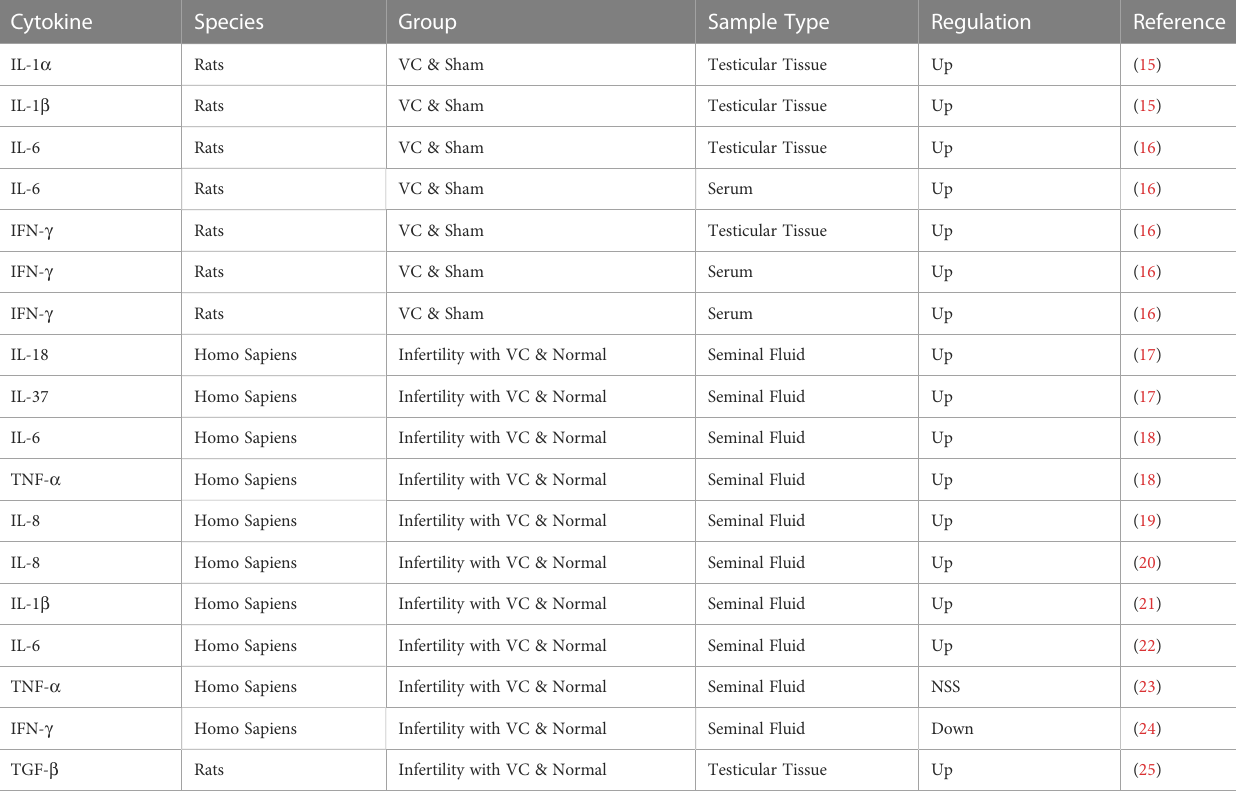
TABLE 1 Cytokines and